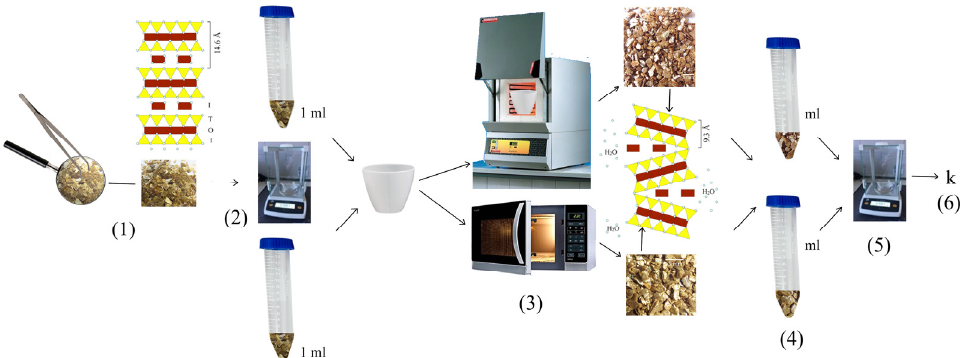
Figure 2. Illustration of the expansibility. ( 1 ) Cleaning of vermiculite by hand-picking of minerals other than vermiculite. ( 2 ) Weight of the raw sample occupying a volume of 1 mL. ( 3 ) Vermiculite expansion by heating in an electric furnace at different temperatures and by microwave irradiation.